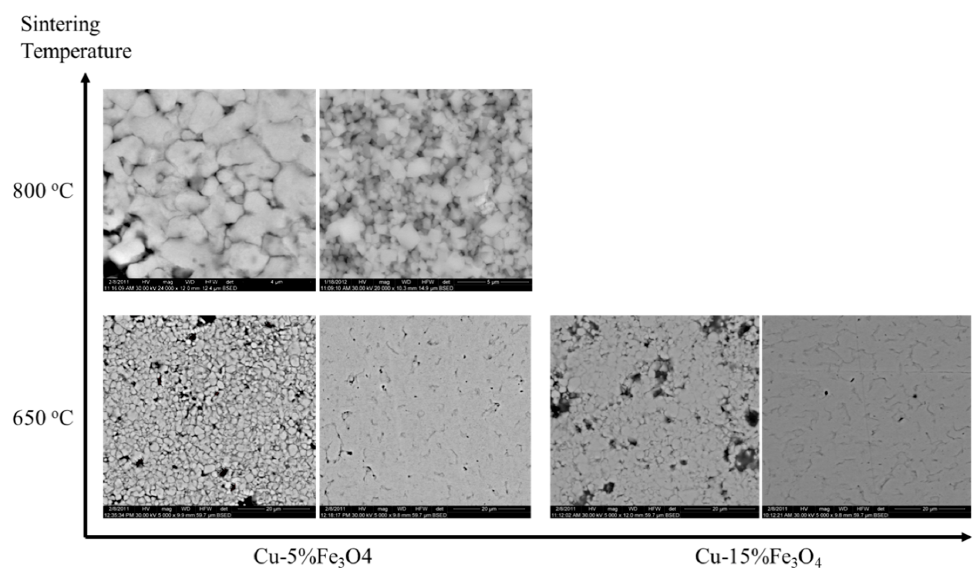
Figure 12. BSED microscopy images of Cu-x%Fe 3 O 4 , where x = 5 and 15; each sintering condition has two images: before (left) and after (right) sintering.